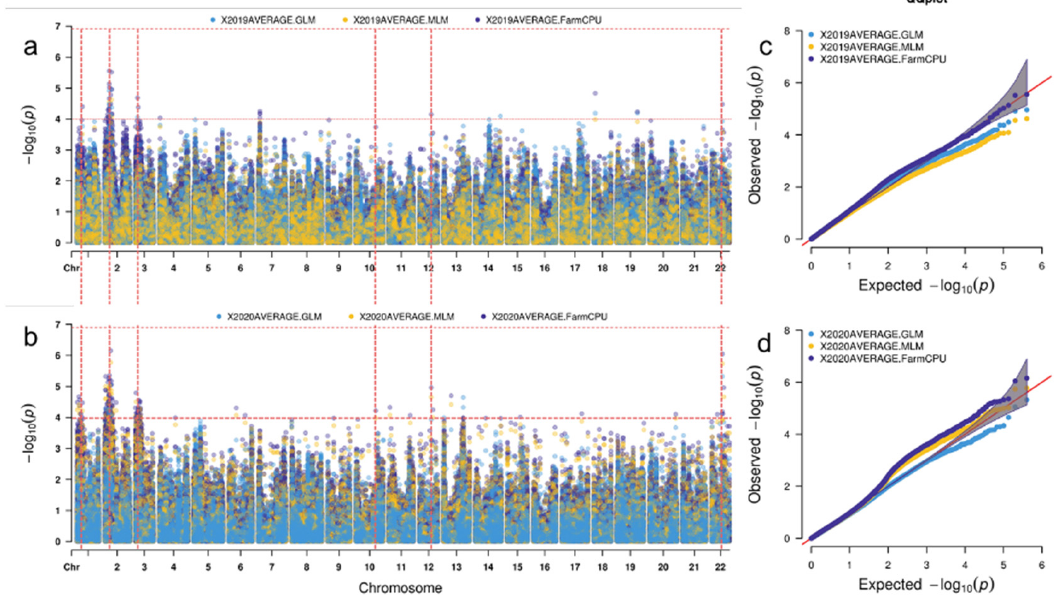
Figure 4. Genome-wide association analysis of CR resistance. Manhattan map and QQ plot map ( a ); ( c ) sowing time is 2019; ( b , d ) sowing time is 2020. The X -axis and Y -axis of QQ graph represent − log ( p -value) of each SNP. The predicted line is a dotted line with an angle of 45 ◦ from the origin. Its deviation indicates that the actual value deviates from the predicted value. The SNP point has a large deviation, so it is considered that the deviation of the observed value of this SNP site is caused by the genetic effect caused by this SNP mutation. Table 3. SNPs significantly associated with both years.